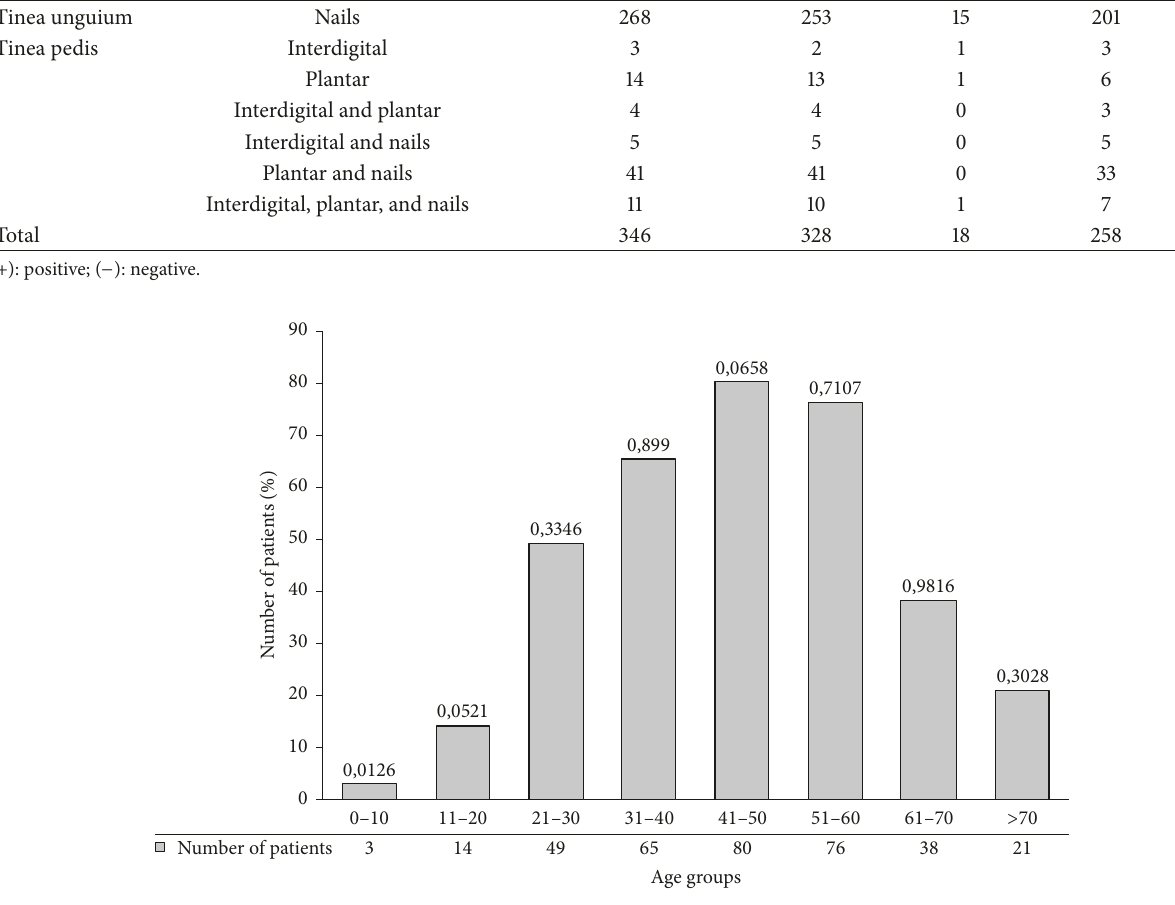
Figure 1: Frequency of foot mycoses according to age groups. Percentage of patients with foot mycoses according to different age groups. 𝑝 value is mentioned under each histogram.